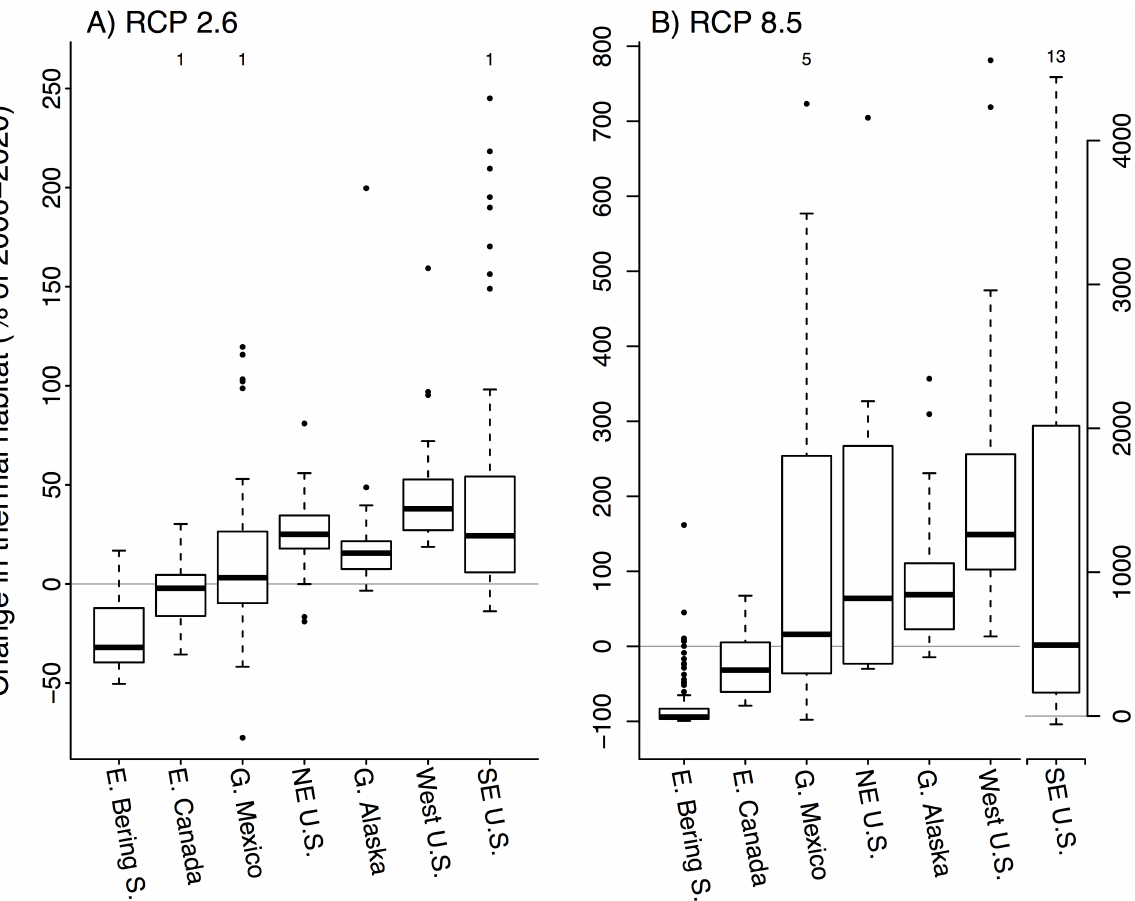
Fig 6. Projected change in thermal habitat availability. Mean percentage change in projected thermal habitat availability over the 21 st century for low uncertainty species originating from seven regions of the North American shelf for (A) RCP 2.6 and (B) RCP 8.5. Boxes indicate the median and the 25 th and 75 th percentiles, whiskers extend to within 1.5 of the interquartile range or to data extremes. Number of extreme data points occurring out of the plotting range is indicated for each region at the top. The right y-axis in (B) applies to SE U.S. only. Sample size for each region is provided in Table